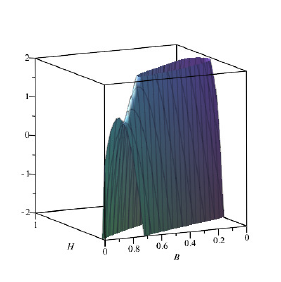
Figure 8. The factor f ( B,H ) in the Theorem 3 that presents changes of